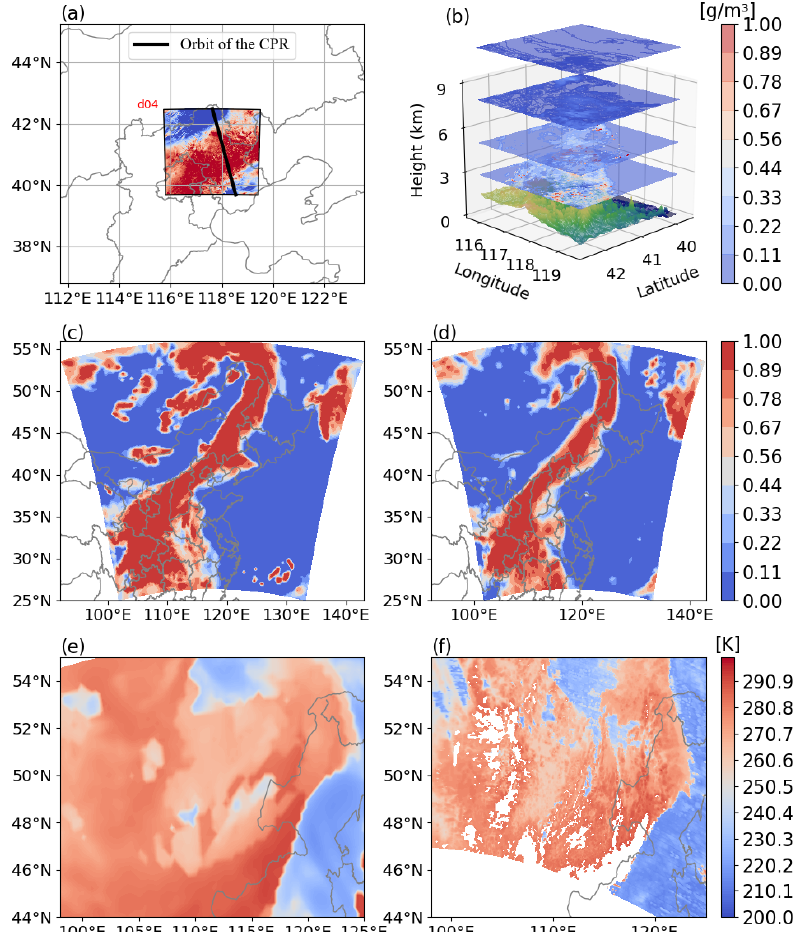
Figure 8. Simulation area exhibition of the stratiform cloud case scenario and comparison between the WRF model results and observation data. (a) Exhibition of the internal two-layer simulation area, (b) three-dimensional distribution of the total hydrometeor output from the WRF, (c) fraction of cloud cover from the WRF model, (d) fraction of cloud cover from the ERA5 data, (e) WRF model-simulated cloud-top temperature, and (f) MODIS-observed cloud-top